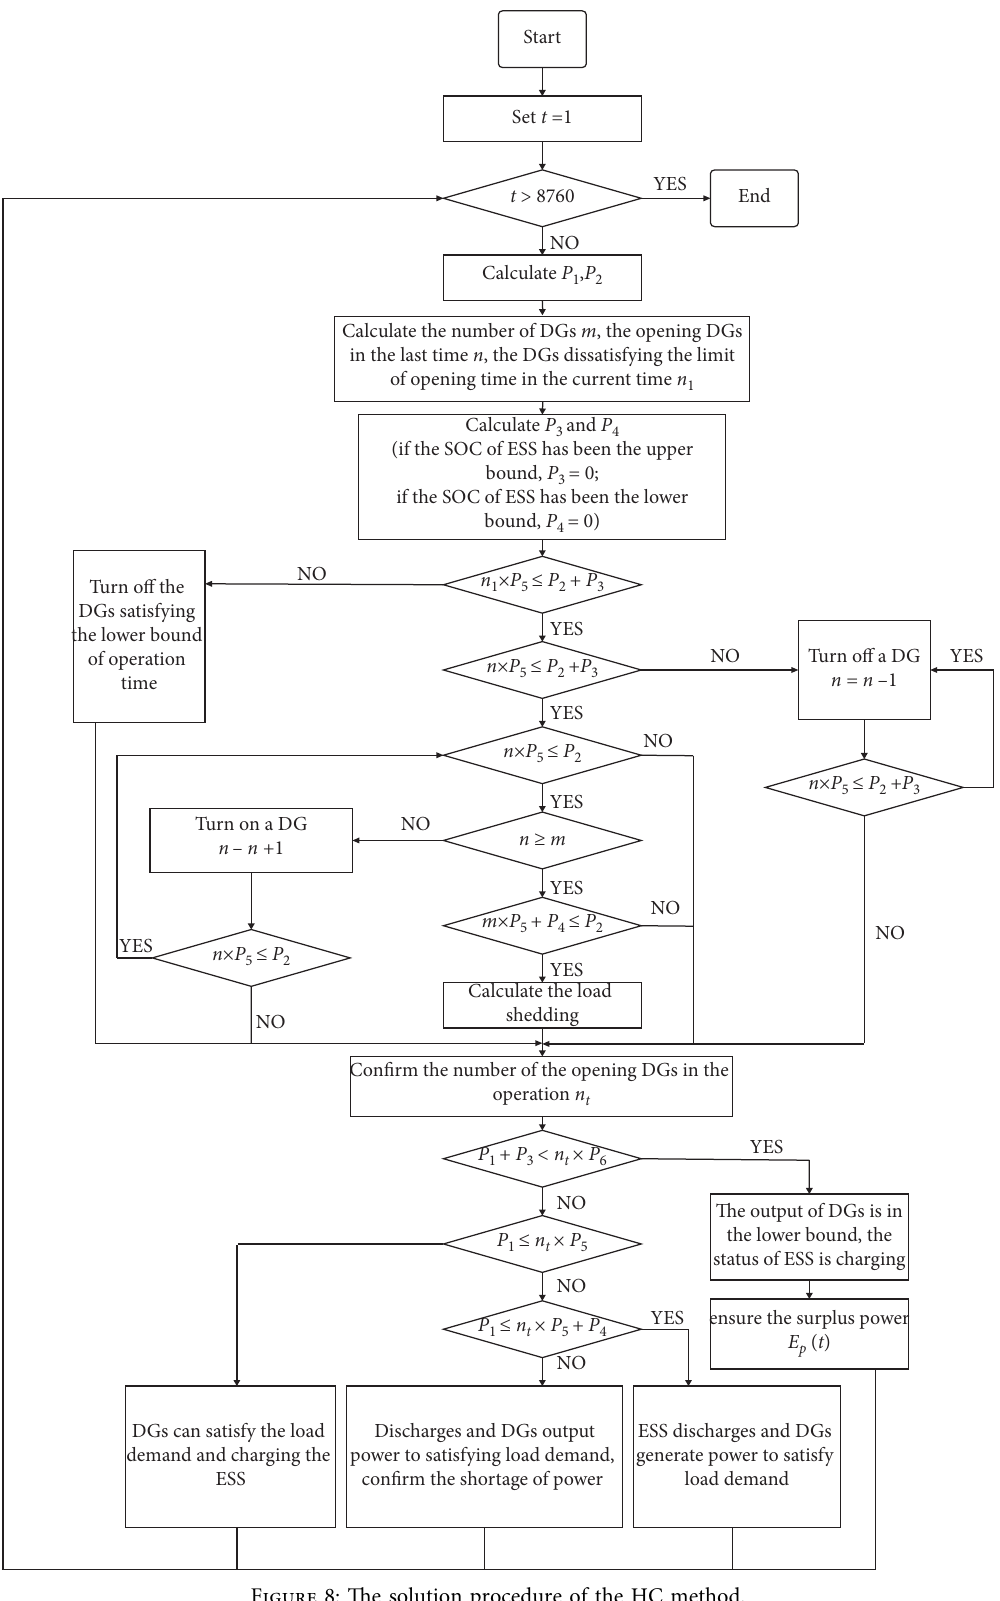
Figure 8: The solution procedure of the HC